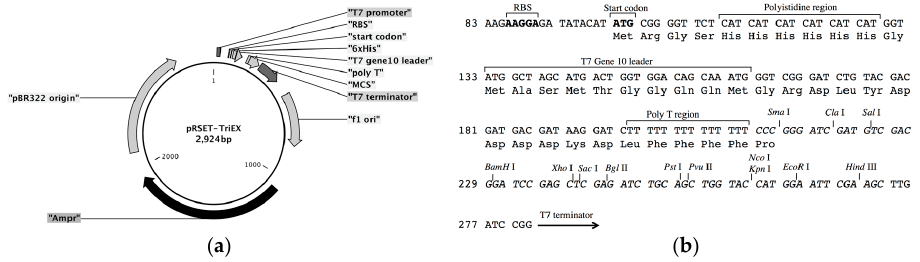
Figure 2. Structure of frame-insensitive bacterial expression cloning vector, pRSET-TriEX. ( a ) Vector map of pRSET-TriEX. ( b ) Detailed information around multiple cloning site (MCS). The DNA sequence (dT) 14 and restriction enzyme sites (SmaI, ClaI, and SalI) are inserted after original start codon of pRSET B.